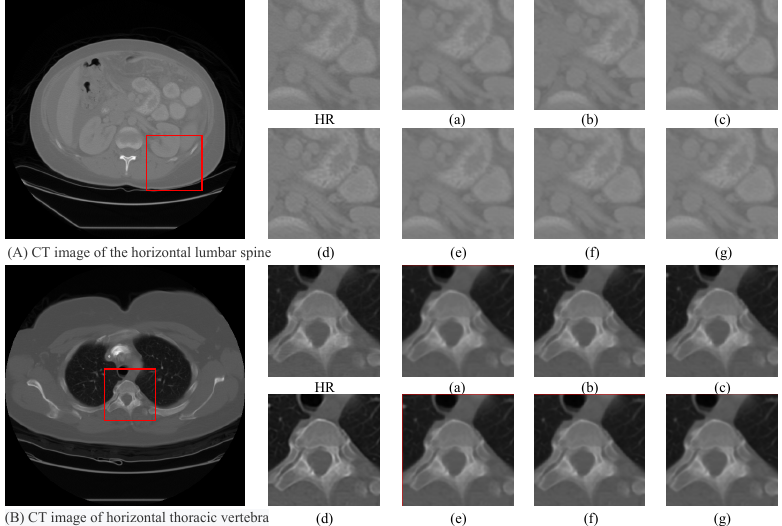
Figure 6. Qualitative comparison of ablation study at × 2 super-resolution CT